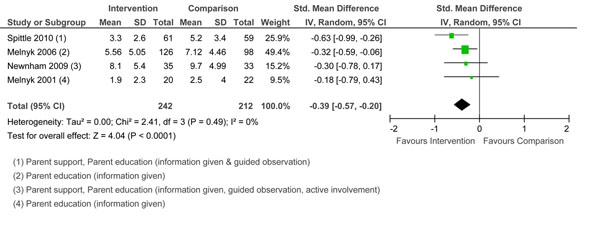
Forest plot of comparison: 1 Group, outcome: 1.2 Depressive symptoms.